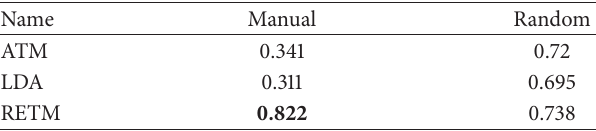
Table 5: Accuracy rate of topics models for records with different